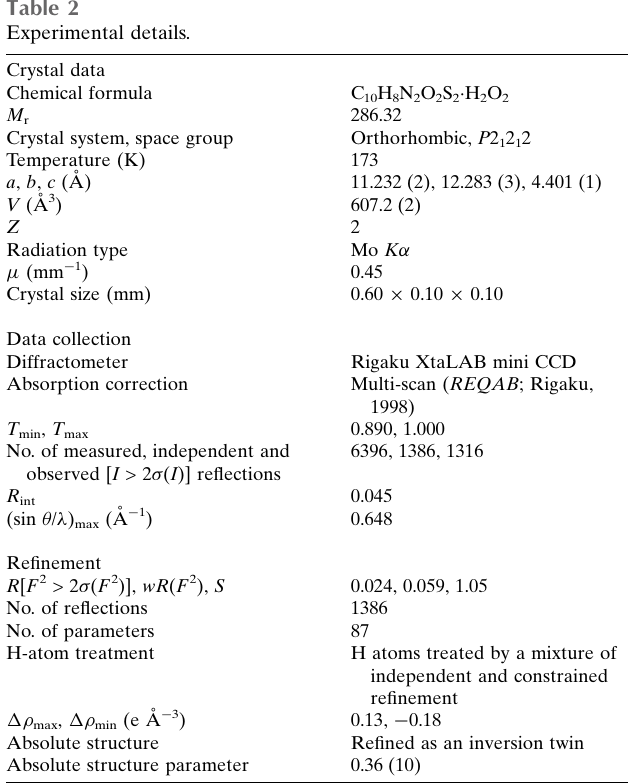
Table 2 Experimental details.